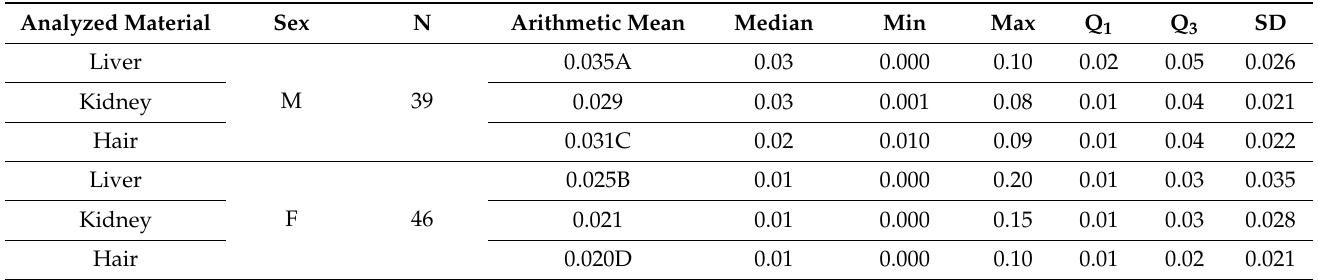
Table 3. Contents of mercury in cat organs depending on sex in milligrams per kilogram. Letters signify highly significant differences at p ≤ 0.01.